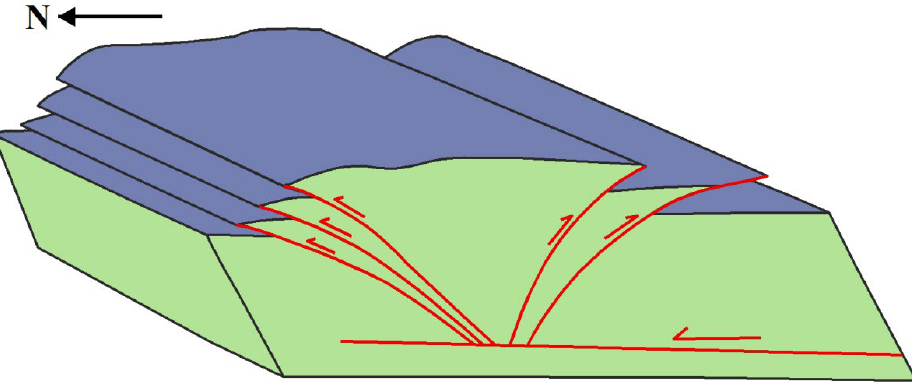
Figure 10. A schematic model of the pop-up structure for the study area in the north–south direction.